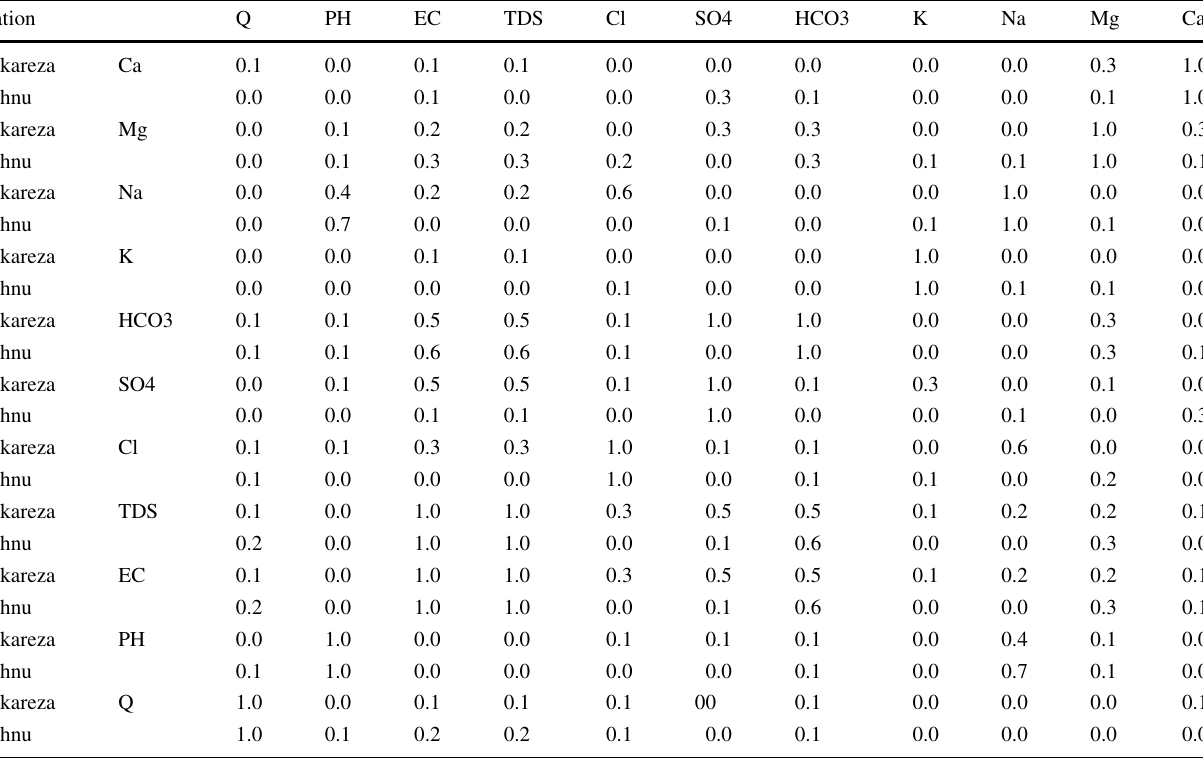
Table 3 Correlation coefficient between ions Station